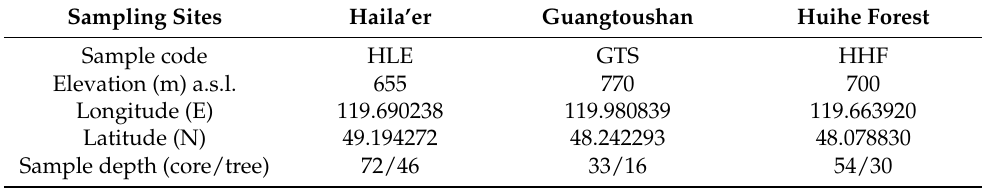
Table 1. Basic information about the three locations where the tree cores were collected.